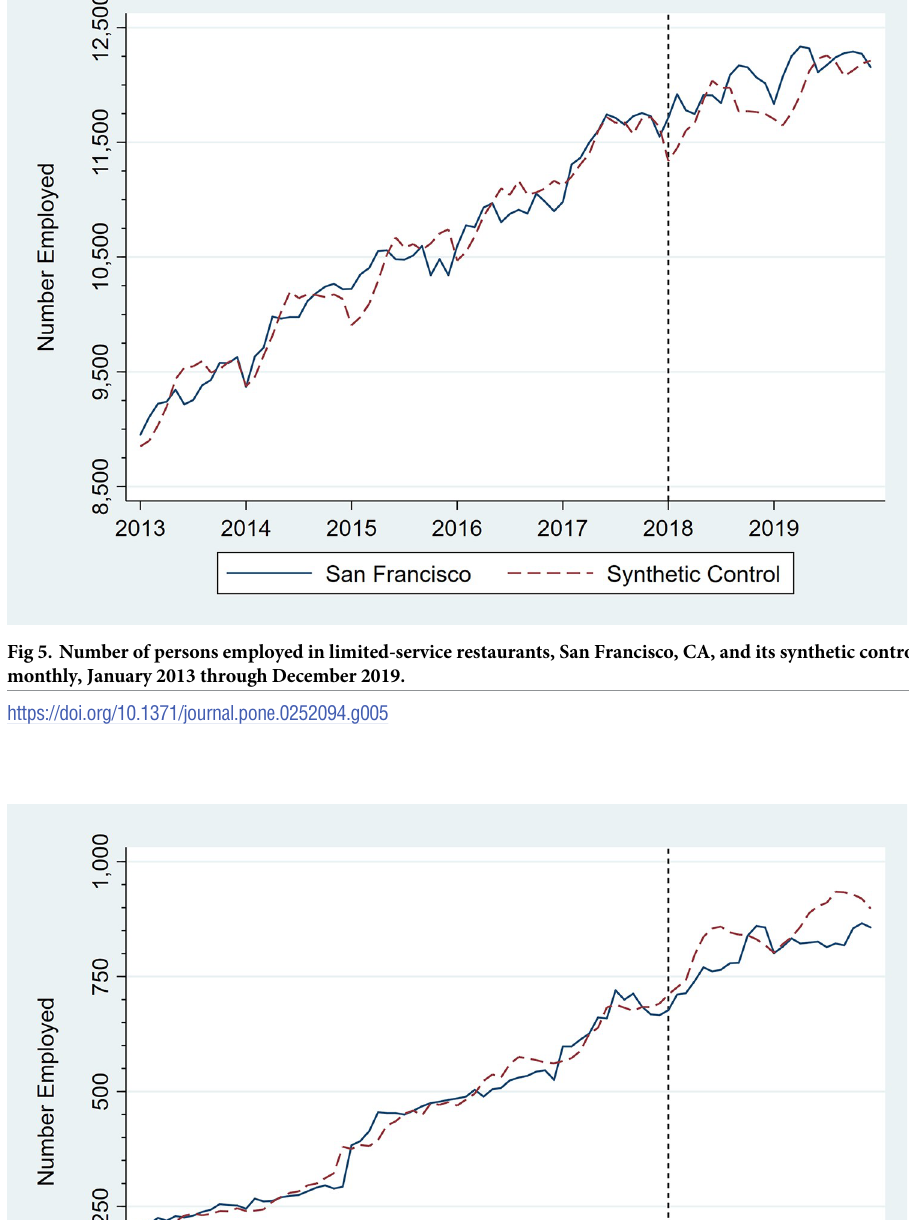
PLOS ONE | https://doi.org/10.1371/journal.pone.0252094 June 2,